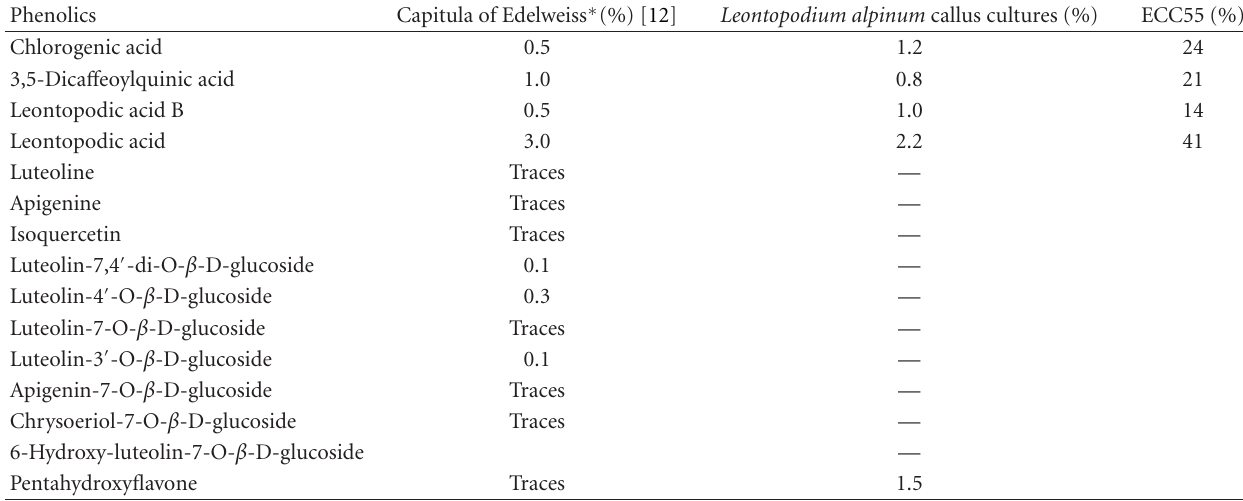
Table 1: Quantification of phenolic extracts of aerial parts of Edelweiss plant, Leontopodium alpinum callus cultures, and concentrated extract enriched in leontopodic acids